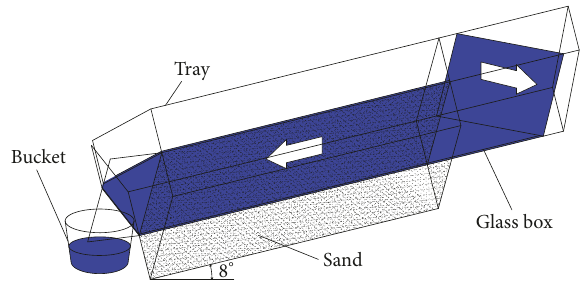
Figure 4: The runoff erosion